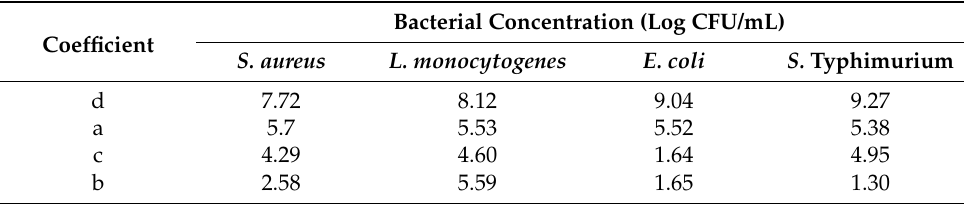
Table 5. Regression coefficients for bacterial growth kinetics (control samples).